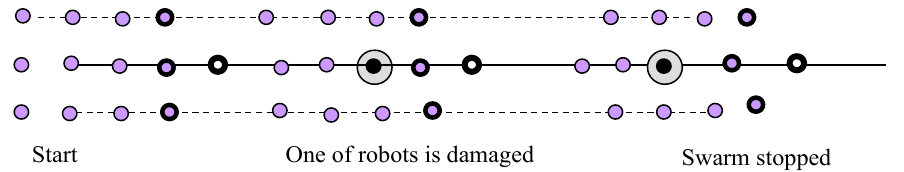
Figure 15. The effect of robot fault on swarm array.